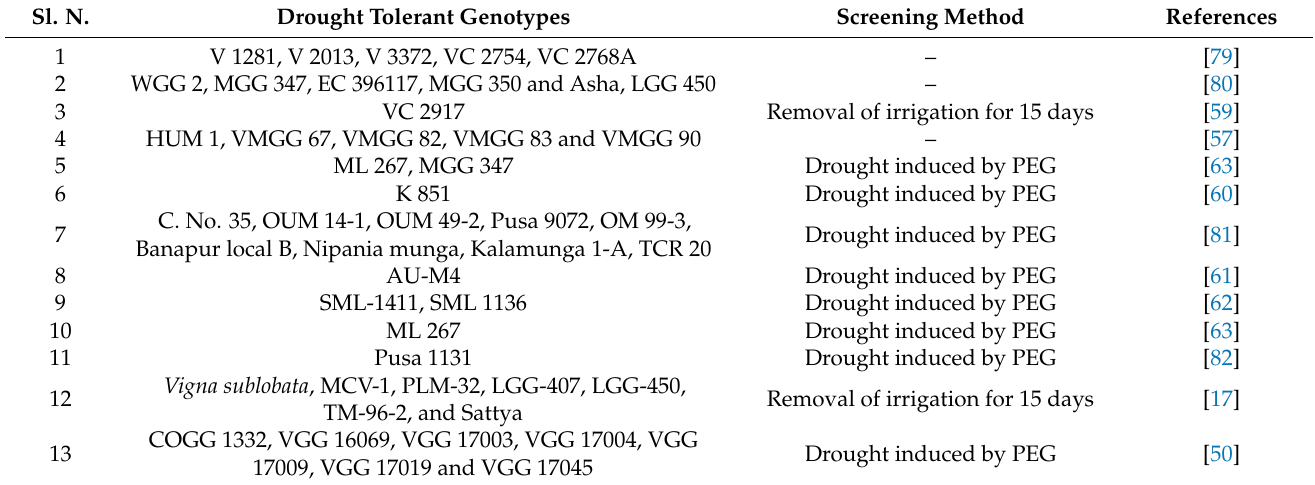
Table 2. Potential donors for drought tolerance in mungbean. Sl.